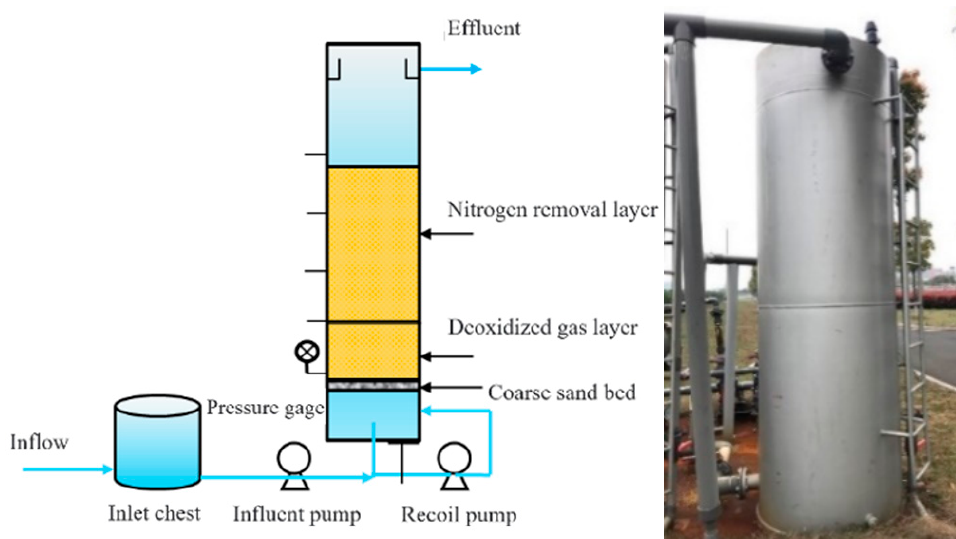
Figure 2. Schematic diagram of the pilot-scale bioreactor.